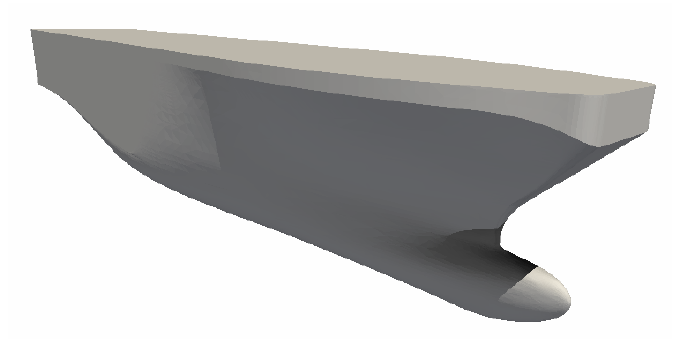
Figure 6. The baseline